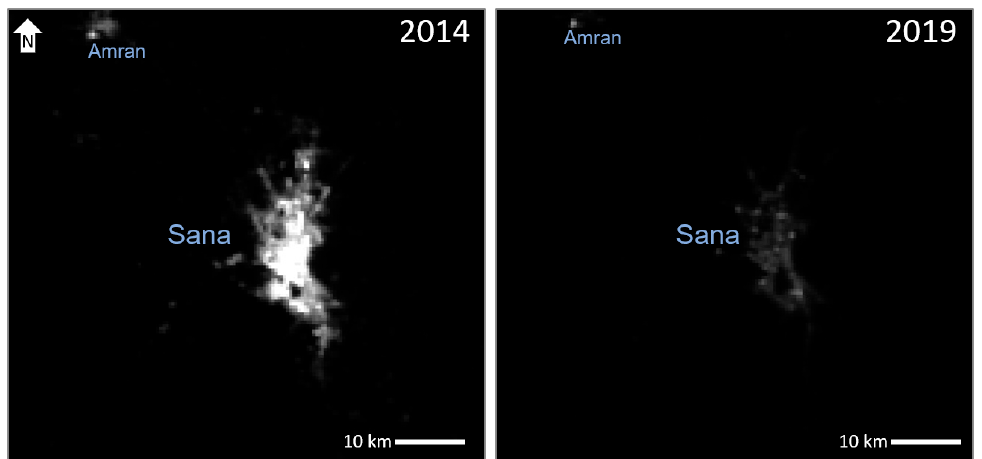
Figure 6. The Suomi National Polar-Orbiting Partnership Visible Infrared Imaging Radiometer Suite sensor (NPP-VIIRS) night-time light images of Sana, Yemen, during the years 2014 and 2019. Remote Sens. 2019 , 11 , x FOR PEER REVIEW